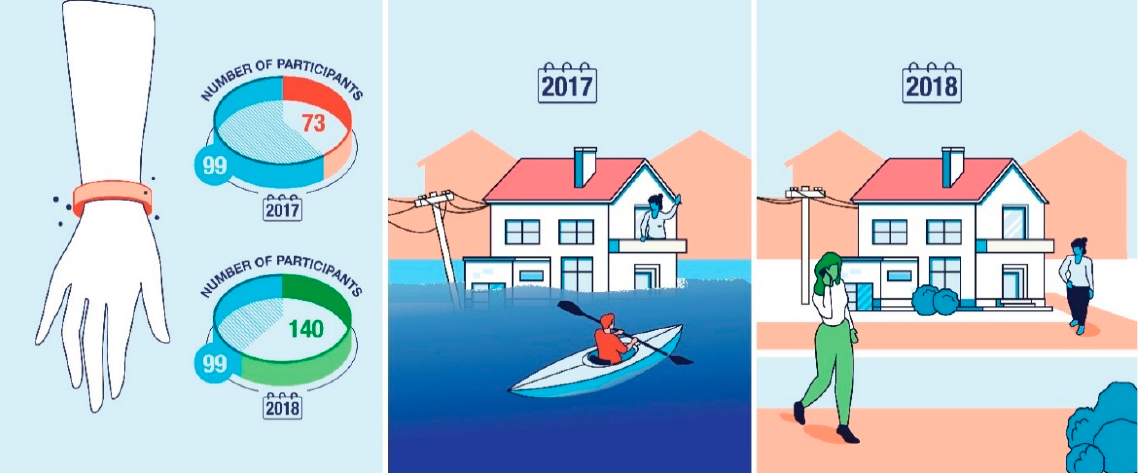
Figure 1. Participants wore and returned a silicone wristband during a post-hurricane timepoint in 2017 (n = 172, 83% compliance), and again one year later, in 2018 (n = 239, 90% compliance). The 2018 timepoint was utilized as an estimated baseline of chemical exposure in non-disaster conditions in Houston, TX. A longitudinal panel (n = 99, 79% compliance) participated in both the post-hurricane and estimated-baseline timepoints.